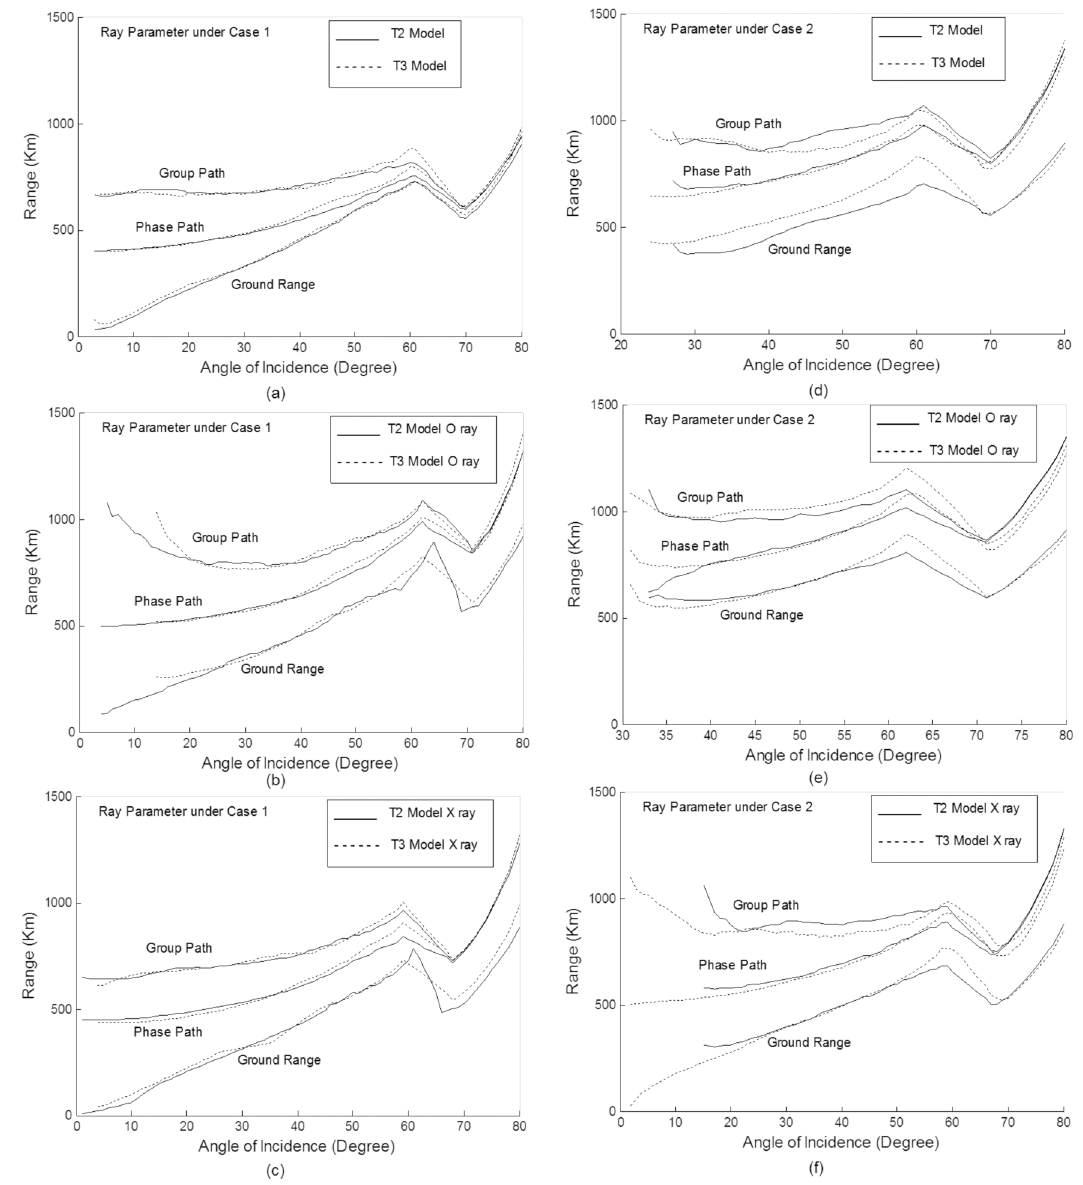
Figure 8. Ray tracing parameter variation for different angle of incidence at 7.5 MHz for T2 and T3 model of the ionosphere: (a) without magnetic field under Case 1, (b) O mode under Case 1, (c) X mode under Case 1, (d) without Earth’s magnetic field under Case 2, (e) O mode under Case 2, (f) X mode under Case 2.